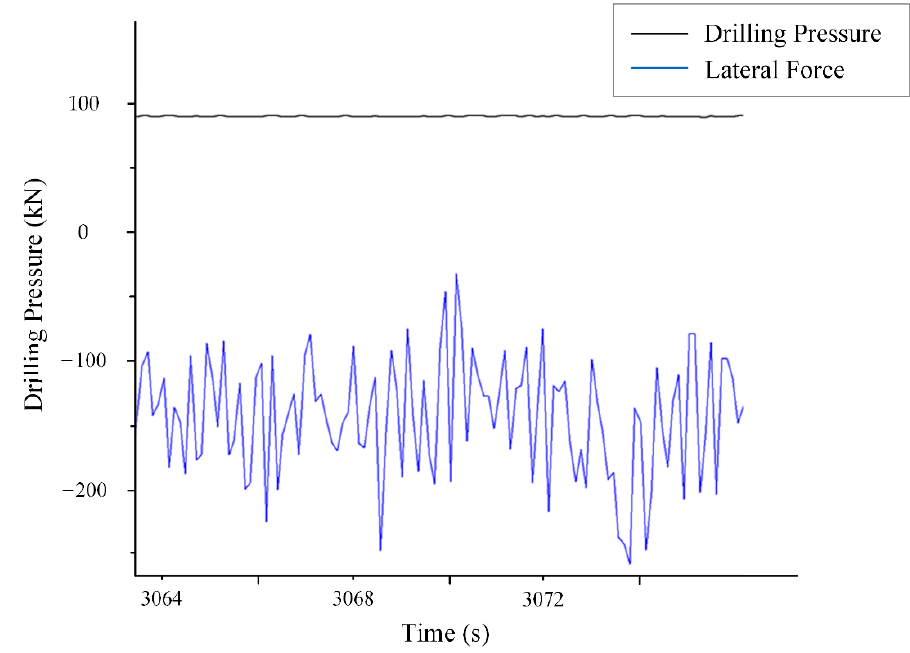
Figure 11. Partial enlargement of relationship between the lateral force and drilling pressure.